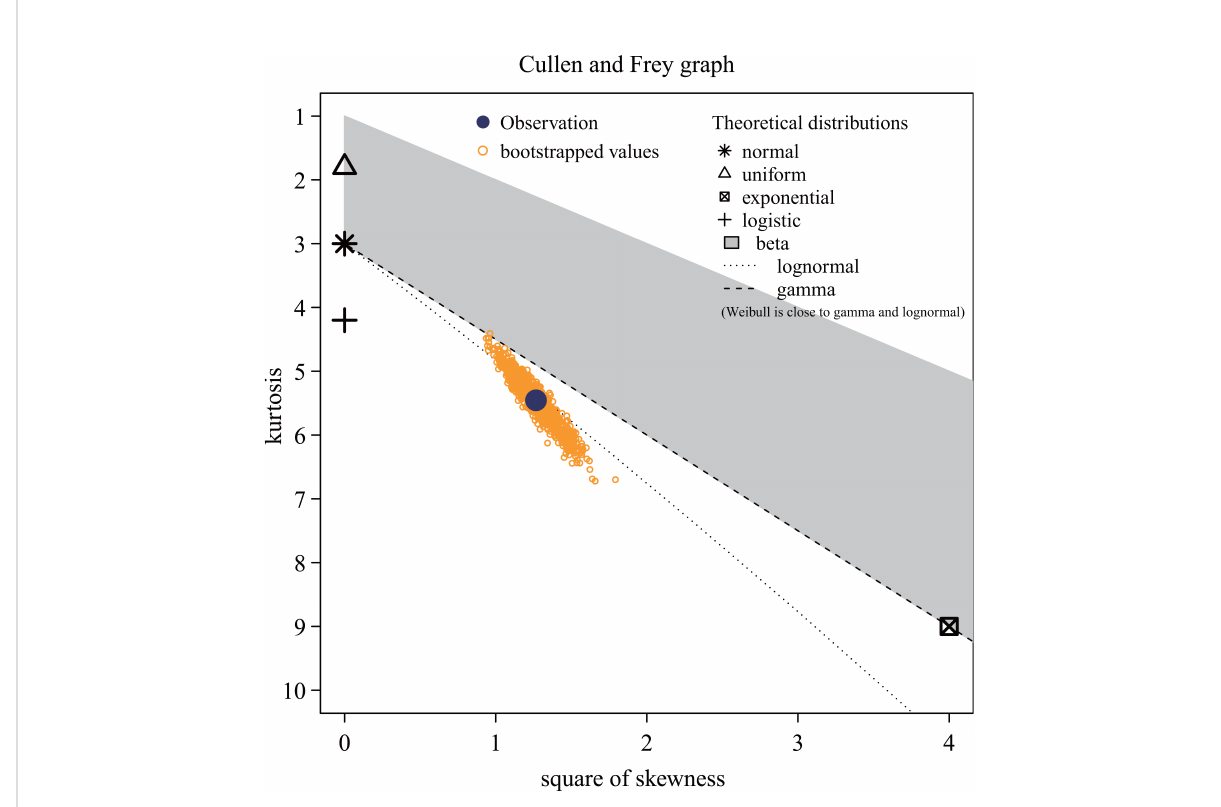
FIGURE 3 Distribution of projected recruitment data. These yellow dots represent the step values, while the different symbols represent the various distribution models. The distribution type of the data is the theoretical distribution represented by the nearest symbol of the observed value (blue solid dots). The horizontal and vertical axes indicate skewness and kurtosis, respectively.